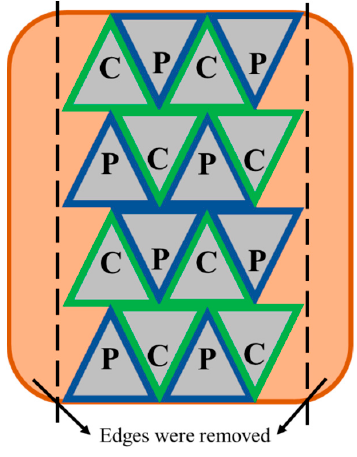
Figure 1. Meat sampling position of the control untreated (C) and the pulsed electric field (PEF)- treated (P) samples on the whole brisket. The edges of the brisket which were too thin for PEF processing were removed. In order to minimise the inconsistency due to muscle inhomogeneity, sampling was performed by allocating the C and P adjacent to each other. The meat was cut into triangular pieces of about 70 g with dimensions of 6 cm in height, 4 cm in width and 6 cm in length for PEF treatment.